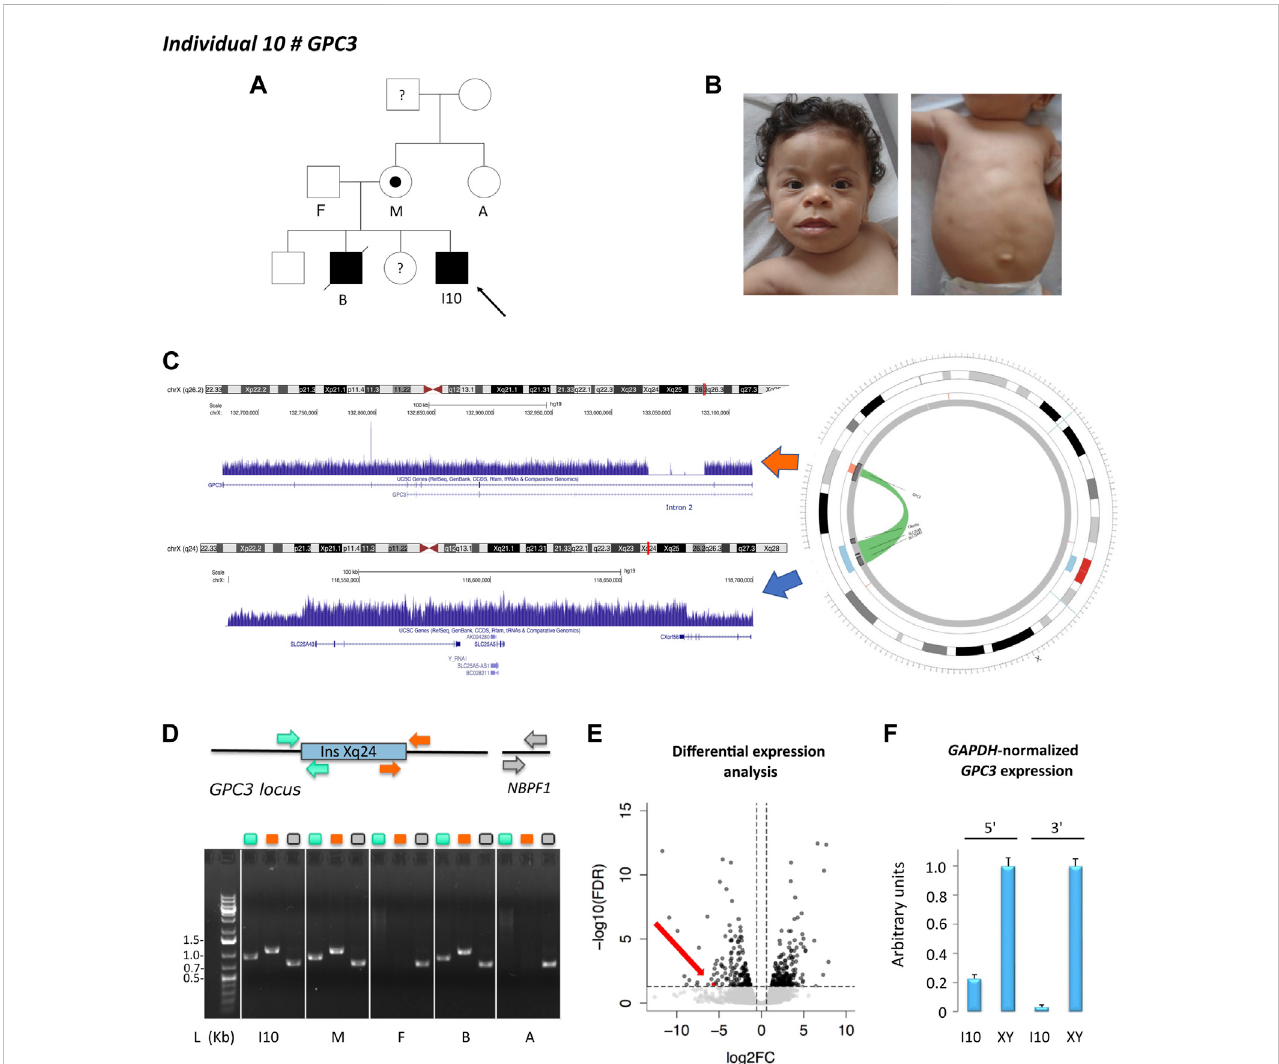
FIGURE 2 Individual 10 — Simpson-Golabi-Behmel syndrome, type 1, MIM 312870. (A) Pedigree of individual 10. The affected status is indicated by fi lled symbols; the carrier is indicated by a dot symbol. (B) Dysmorphic features include telecanthus, palpebral edema, wide mouth, macroglossia, thin upper lip vermilion, smoothphiltrum,supernumerarynipple,andumbilicalhernia. (C) Xchromosomeideogramand GPC3 andXq24loci.Readdepthtracksshowingadeletionof 30 Kb in intron 2 of GPC3 and an Xq24 duplication encompassing SLC25A43 , SLC25A5 , and the fi rst exon of CXorf56 . Split-read analysis indicated that thesecopynumbervariantsbelongedtothesameeventinvolvingtheinsertionoftheXq24regionwithinthedeletedintronicregionof GPC3, visualizedinthe circosplot. (D) Schematicrepresentationofthe Xq24 insertion inthe GPC3 locusandthecontrolregion NBPF1 .Theinsertion-deletioneventwasvalidatedby PCR using two couples of primers as indicated in the color scheme. Gel lanes are labeled according to the primer scheme. L: ladder, I10: index case, M: mother, F: father, B: brother, A: aunt. (E) RNA-sequencing differential expression analysis in fi broblast cell line showing loss of GPC3 expression (red dot. and arrow)inindividual 10as comparedtoacelllineobtained fromahealthy(unaffected)male. (F) qPCRresultsat5 ′ and3 ′ .EndsofGPC3cDNA.Theresultswere normalized according to GAPDH expression and represented as relative expression, according to a healthy (unaffected) male